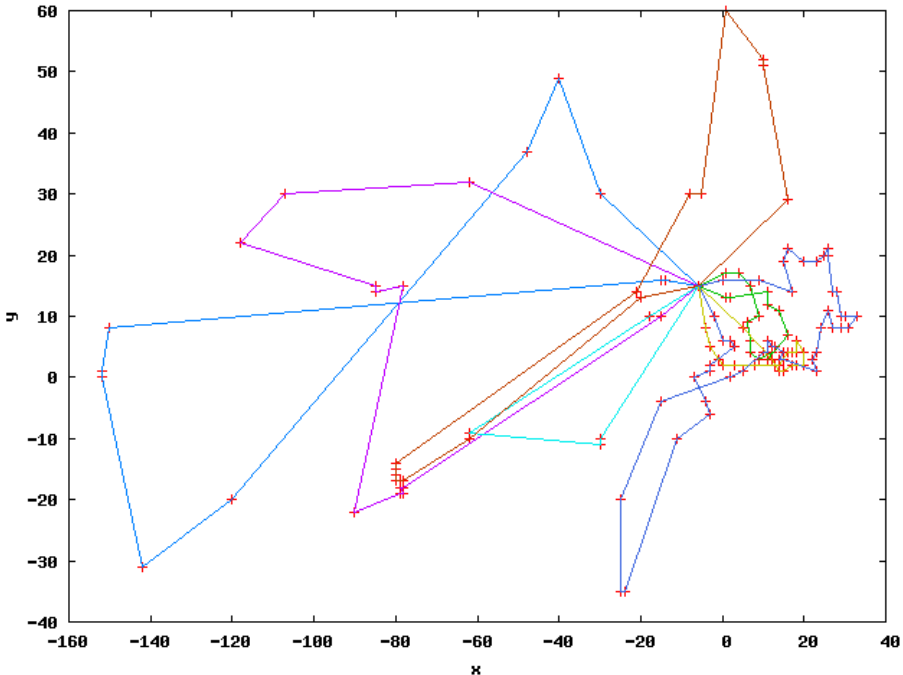
Figure 21. Best combinations, long, large examples experiment–example for largest Fisher set F, with fitness distance from best known one around